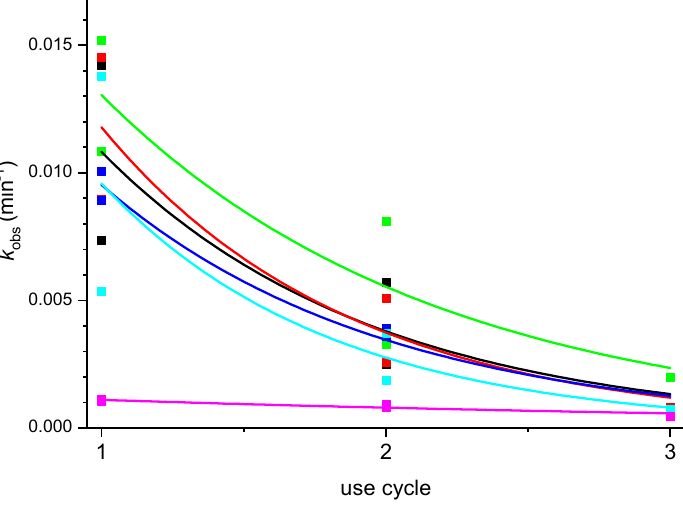
Figure 7. Observed first ‐ order rate constants k obs as a function of use cycle of the catalyst Pd ‐ PPy ‐ PS at initial catalyst Pd concentrations of 1.8 μ M for the homocoupling reaction of 150 μ M 1 in pH 9 borate buffer (10 mM) over the course of 72 h at 30 °C in the presence of 4.4 M (black), 4 M (red), 3 M (green), 2 M (blue), 1 M (cyan), and 0 M (magenta) chloride. Lines are fits of a first ‐ order kinetic model to the data.